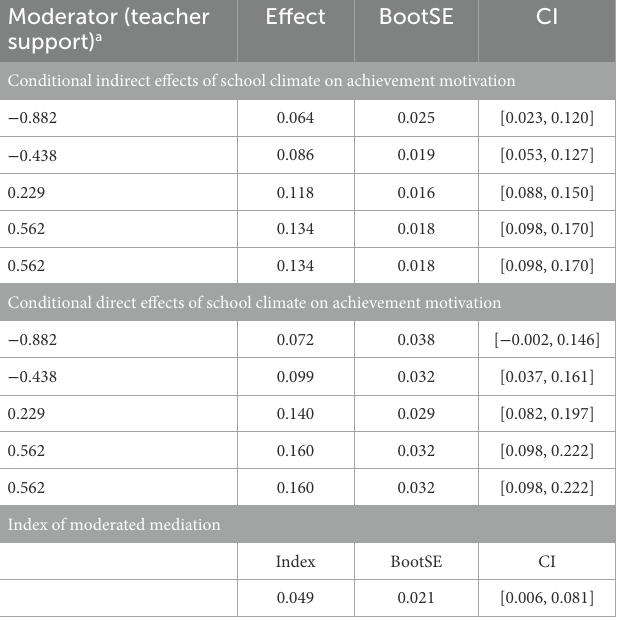
TABLE 3 The direct and indirect effects of school climate on achievement